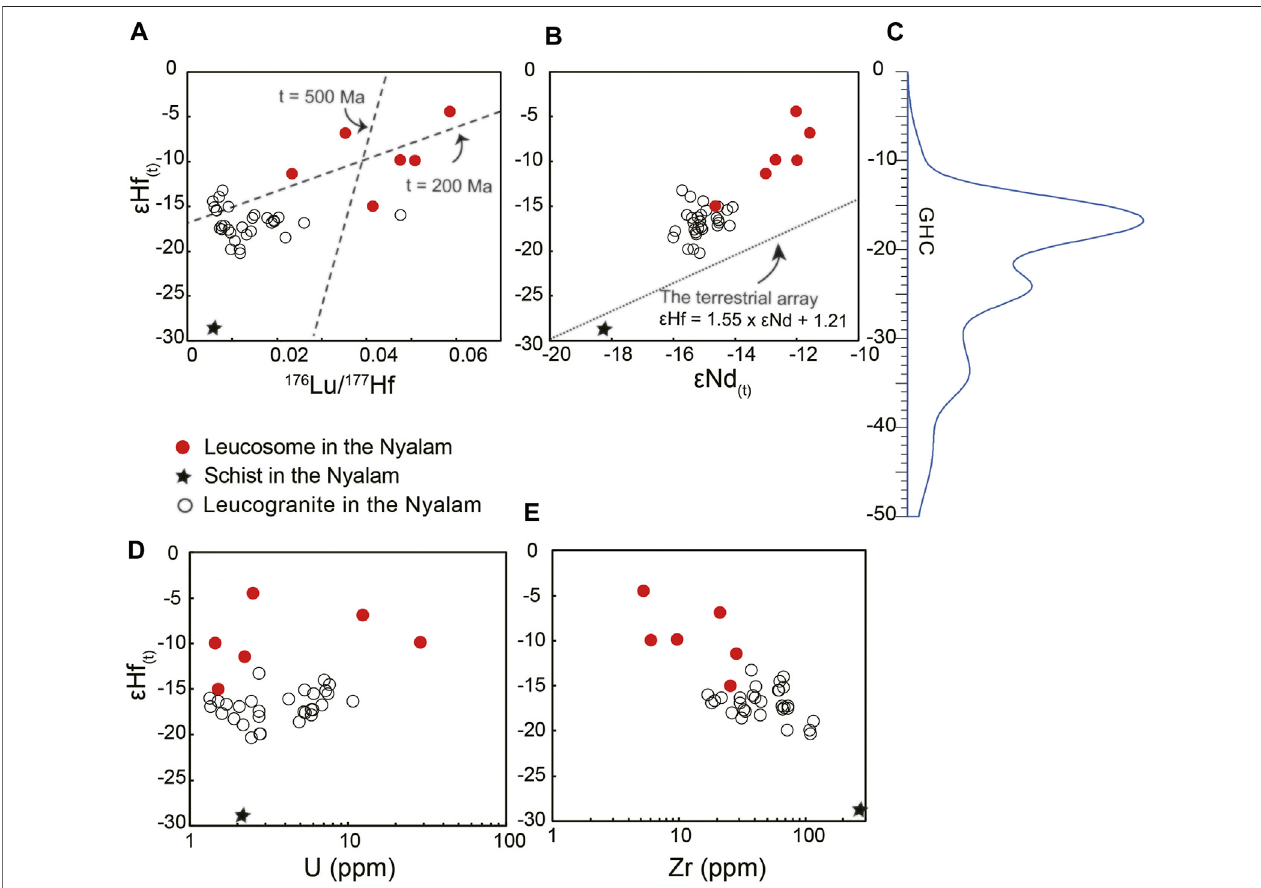
FIGURE 6 | Plots of ε Hf (t) vs. (A) 176 Lu/ 177 Hf, (B) ε Nd (t) , (D) U, and (E) Zr for the leucosome, schist, and leucogranite in the Nyalam. The dashed lines in the (A) indicate the500Ma and 200Maerrorchrons. Thedottedlinein the (B) shows theterrestrialarray regressed byVervoort et al. (2011). (C) The kernel density estimates of the GHC (Langtang) detrital zircon data, recalculated at 15 Ma, based on the composition of Spencer et al. (2019) ( Supplementary Table S5 ).